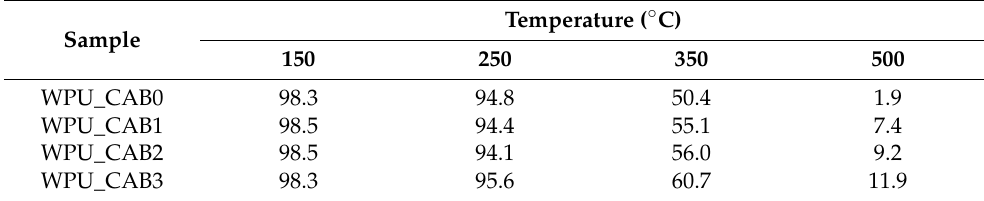
Table 3. Residual amounts (wt.%) of WPU films.